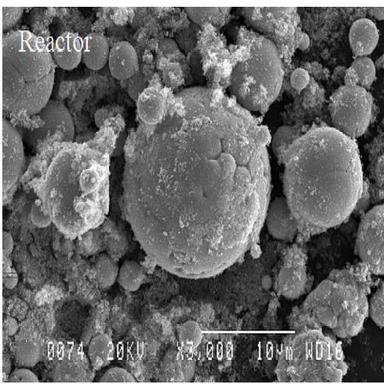
SEM image of the Al-Mo powder particles obtained from the reactor wall.